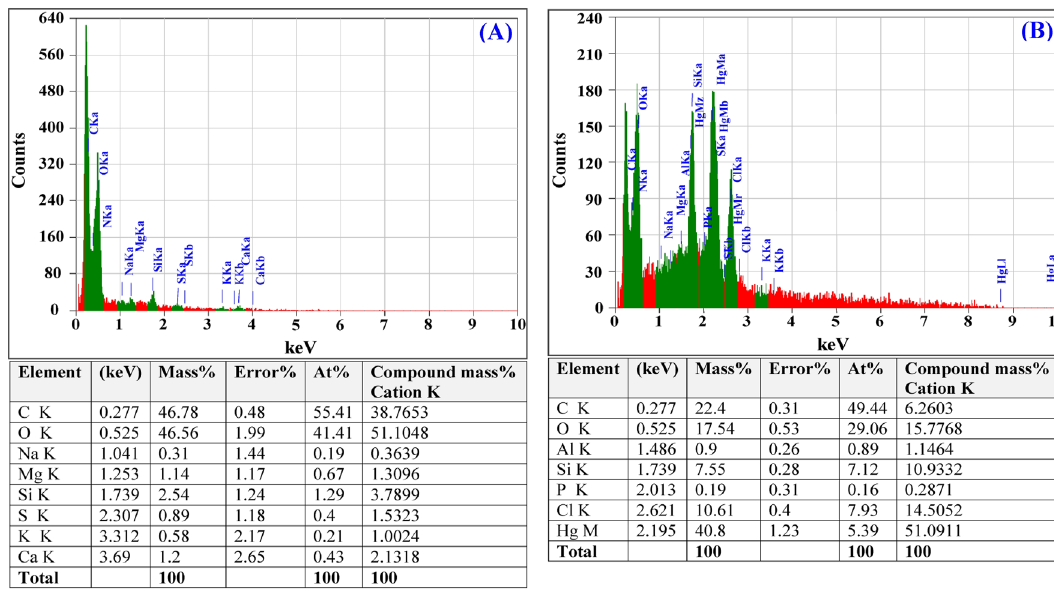
Figure 9. EDS analysis of Gelidium corneum biomass: ( A ) before and ( B ) after simultaneous biosorption of Hg 2+ and Remazol brilliant blue dye.